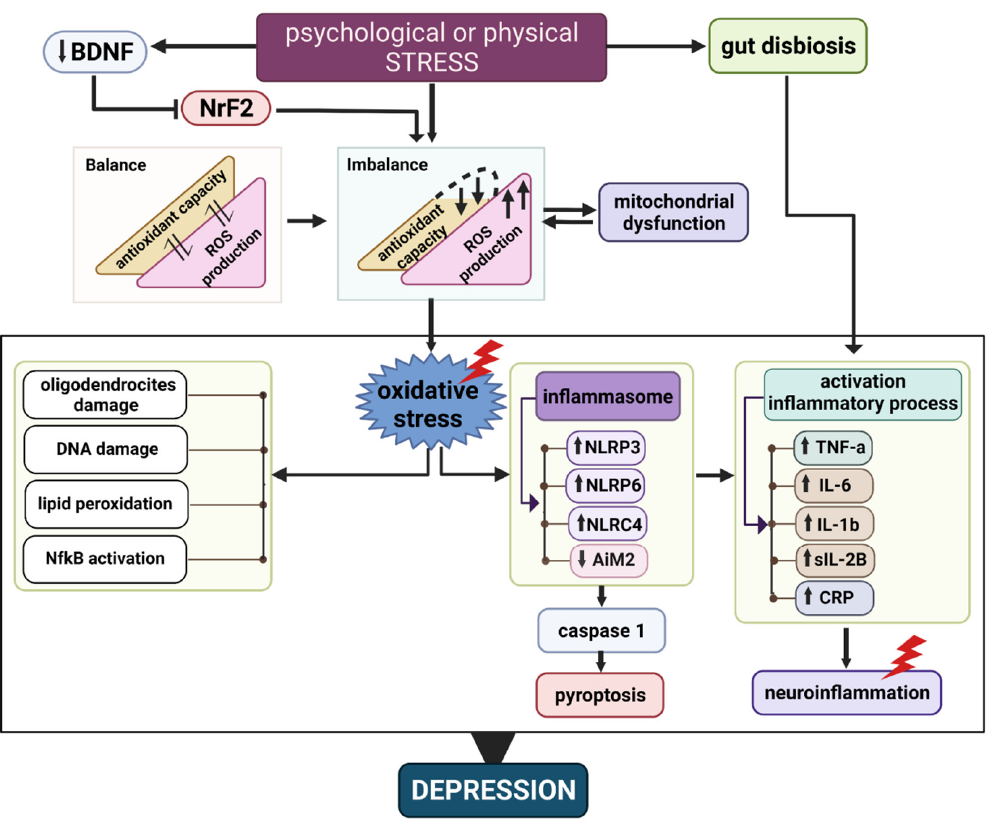
Figure 2. Interaction between oxidative stress and neuroinflammation at the onset of major depressive disorder. Figure shows that psychological and/or physical stressors can trigger the pathophysiology associated with major depression. Once the limit of the brain’s antioxidant capacity has been exceeded, oxidative stress prevails, inducing neuroinflammation and the deterioration of brain cells, which over time leads to the induction of the main phenotype associated with major depressive disorder. Red rays show the possible targets of plant-derived extracts and acellular products derived from mesenchymal stem cells.